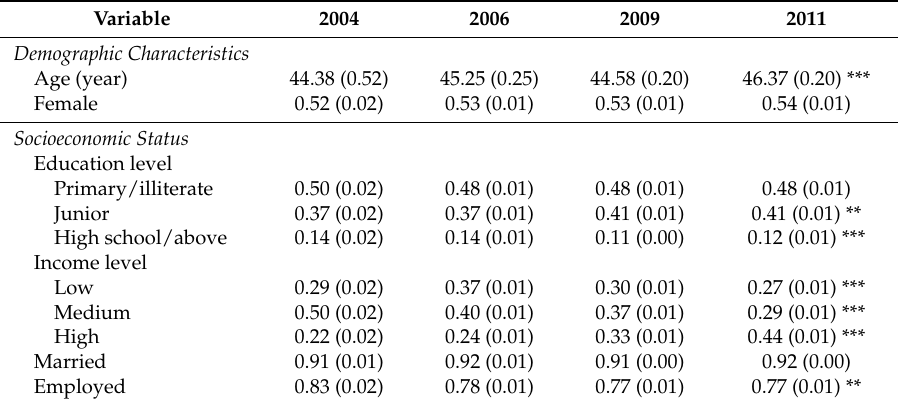
Table A2. Basic characteristics trends of NRCMS participation from 2004 to